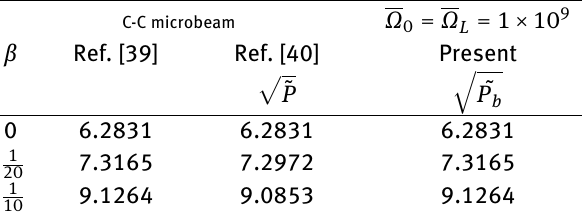
Table 3: Validation study for a clamped-clamped microbar using strain gradient elasticity